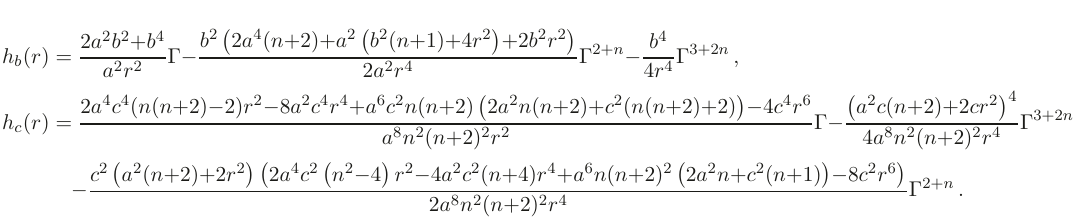
Table 2 . G x ( r, θ ) for the (1 , 0 , n ) family (upper sign) and (1 , 1 , n ) family (lower sign). 1 x 2 C Table 3: (2 , 1 , n ) wave equations Here we present the ( G (0) x , G ( b ) x , G ( c ) x ) for the (2 , 1 , n ) original and supercharged super- 1 x 2 1 x 2 1 x 2 strata